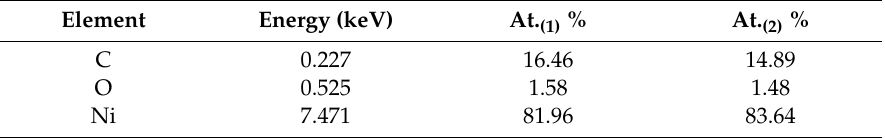
Table 1. EDX data taken from two measurement sites indicated in Figure 3a.